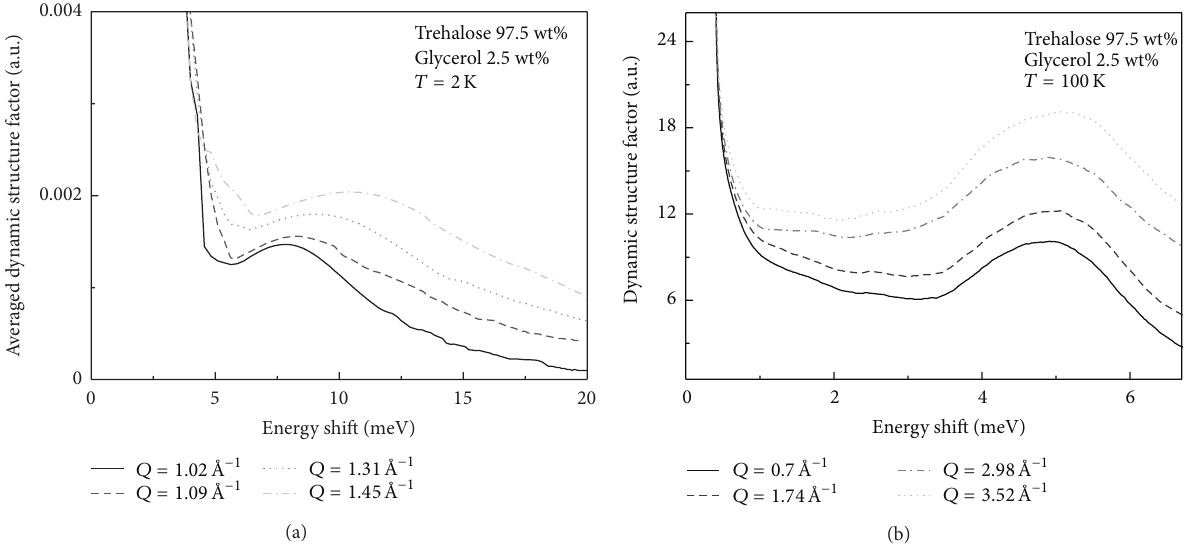
Figure 2: Dynamic structure factor for a trehalose/glycerol mixture at 2.5 wt% of glycerol as a function of the energy shift for different 𝑄 values at (a) T = 2K and (b) T = 100K.